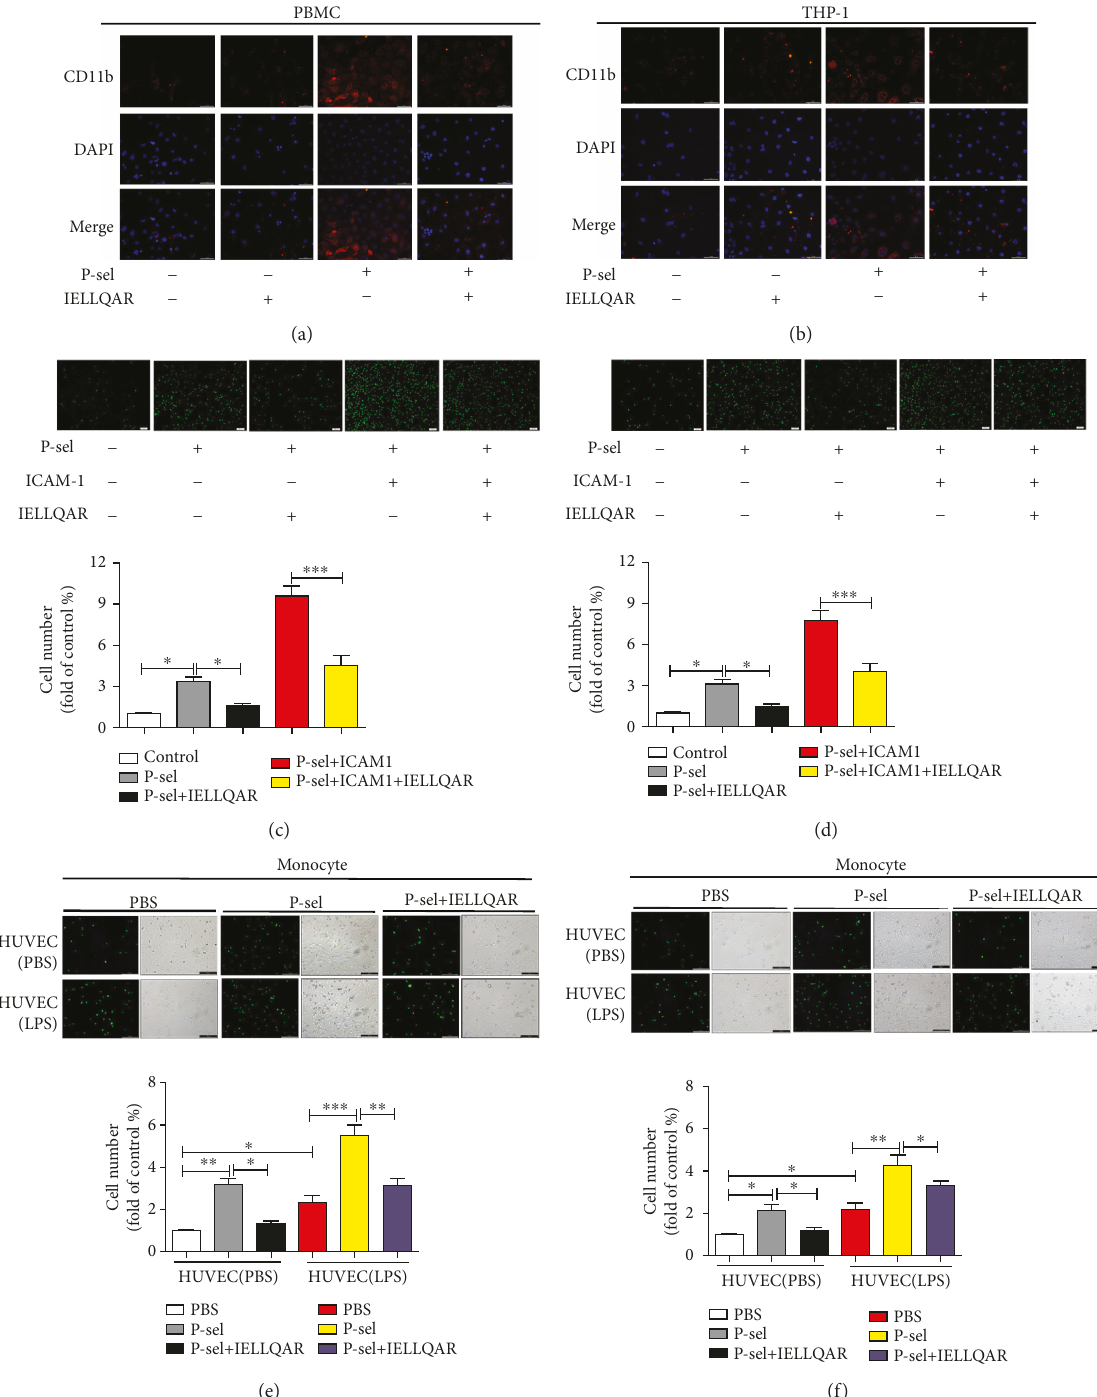
Figure 2: IELLQAR inhibits the adhesion of P-selectin to monocytes and HUVECs. (a, b) PBMCs and THP-1 cells were incubated with PBS, 10 μ g/mL of P-selectin, 10 μ M IELLQAR, or 10 μ g/mL of P-selectin plus 10 μ M IELLQAR for 2 h, respectively. Then, the samples were incubated with anti-human CD11b Ab followed by Alexa Fluor® 555-conjugated rabbit Ab and fl uorescence microscopy scanning. Scale bar: 50 μ m. (c, d) Calcein-AM-labeled PBMCs and THP-1 cells were treated with or without 10 μ M IELLQAR for 2 h. Dishes of parallel plate fl ow chambers were coated with P-selectin, P-selectin plus ICAM-1, or BSA overnight. Then, the cells were perfused through a micro fl uidic fl ow chamber at 2 dynes/cm 2 shear stress for 5 min. Representative photographs of the adhesion of PBMCs and THP-1 cells. Scale bar: 100 μ m. (e, f) Calcein-AM-labeled PBMCs and THP-1 cells were treated with PBS, P-selectin, or IELLQAR plus P-selectin for 2 h. HUVECs were activated or not by pretreating with 2 μ g/mL of LPS for 6 h. Representative photographs of the adhesion of cells on HUVECs. Scale bar: 100 μ m. Data are presented as the mean ± SEM ( n = 3 ). ∗ p < 0 05 , ∗∗ p < 0 01 , and ∗∗∗ p < 0 001